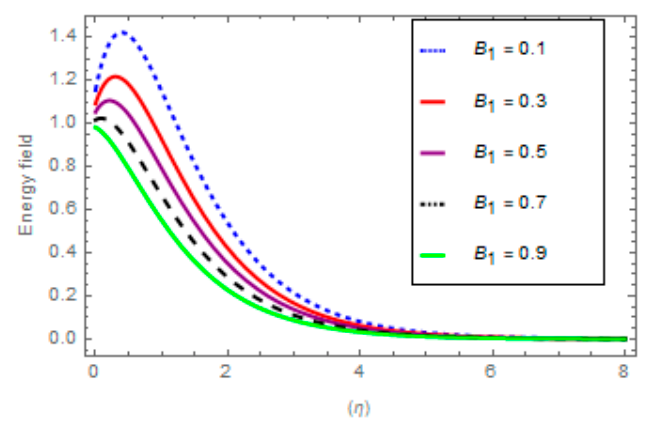
Figure 14. Result of A 1 via θ ( η ) .